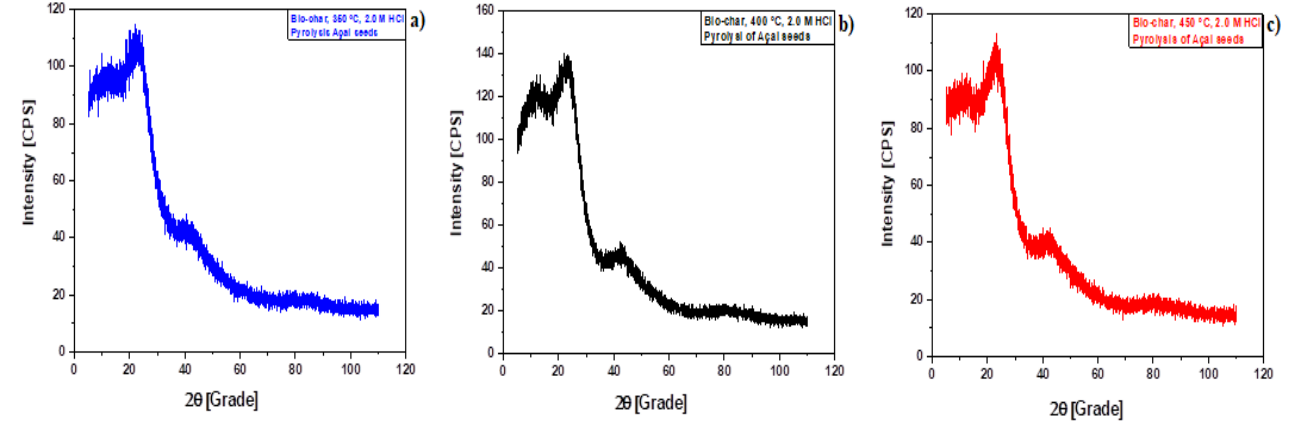
Figure 3. XRD of HCl activated biochar at different temperatures. ( a ) 350 °C; ( b ) 400 °C; ( c ) 450 °C. Table 2. Process parameters, mass balances, yields of reaction products (liquids, solids, H 2 O, and gas), and acidity of bio-oils by pyrolysis of Açaí seeds, activated with 2.0 M KOH solution, at 350, 400, and 450 °C, 1.0 atmosphere, using a borosilicate glass reactor, in laboratory scale.